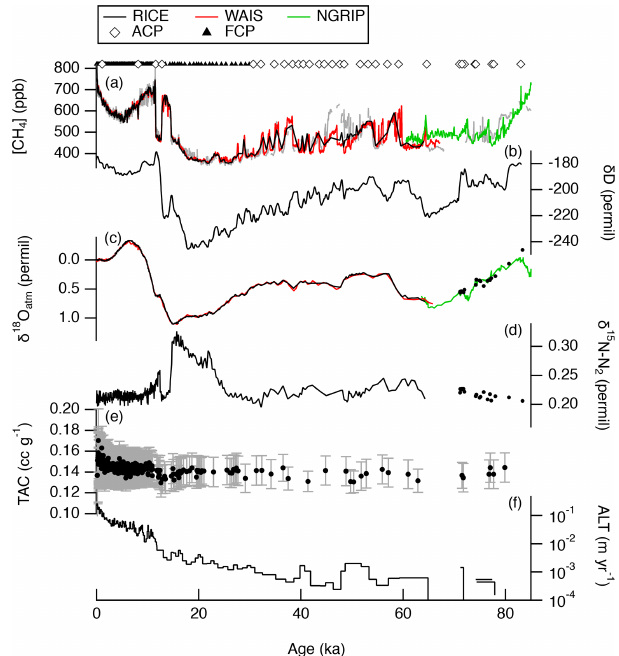
Figure 3. Data from the RICE ice core plotted on the RICE17 age- scale. (a) RICE methane and (c) δ 18 O atm records (gray) shown in comparison to target records from the WAIS Divide ice core on the WD2014 age-scale (Rhodes et al., 2015; Buizert et al., 2015b) (red) and NGRIP ice core (Baumgartner et al., 2014; Landais et al., 2007) on a modified GICC05modelext chronology (Wolff et al., 2010) (green). Solid triangles above panel (a) are gas age constraints from a Monte Carlo analysis; open diamonds are prior ACPs from visual matching (see text). (b) δ D and (d) δ 15 N-N 2 used in a firn densifi- cation model to estimate the ice age–gas age offset. (e) RICE TAC measurements. (f) Mean annual layer thickness calculated from gas age control points adjusted for (cid:49)